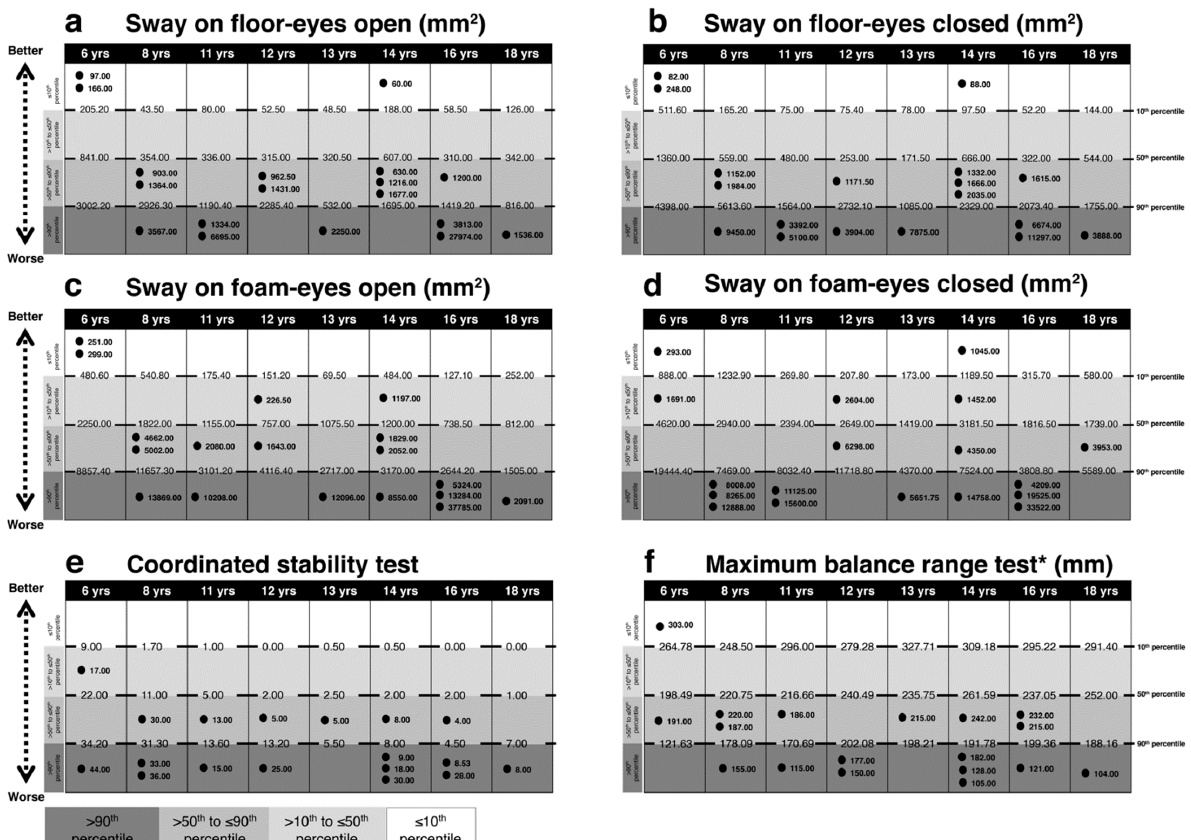
Figure 4. Comparison between each ASD subject’s performance in the PPA balance tests and age-matched reference value (percentiles) for TD subjects. Light gray to dark gray corresponds with better to worse performance. In ( a ) sway on floor eyes open, in ( b ) sway on floor eyes closed, in ( c ) sway on foam eyes open, in ( d ) sway on foam eyes closed, in ( e ) coordinated stability test, in ( f ) maximum balance range test. The reference value of the 10th, 50th and 90th percentiles and each ASD subject values are reported. Intervals for each performance represent: ≤ 10th, 10th < x ≤ 50th, 50th < x ≤ 90th, >90th percentile from the top to the bottom, respectively. * indicates the percentile scale was inverted, i.e., for all items a score over the 90th percentile is an indicator of a worse performance. Abbreviations: yrs, years; mm2, millimeters square; mm, millimeters.